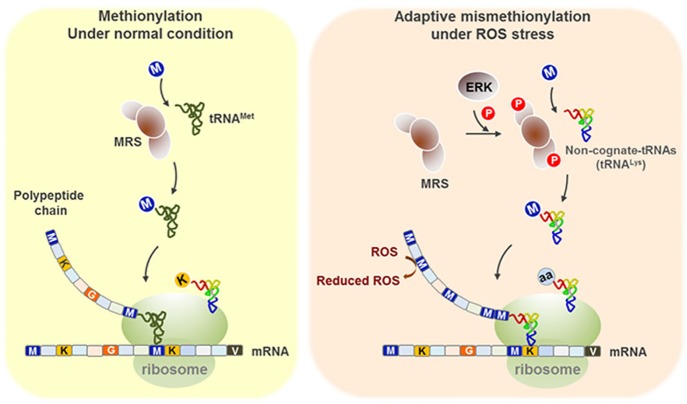
Schematic model for the protective role of MRS under ROS stress. Upon ROS stress, ERK is activated and phosphorylates MRS at the Ser209 and Ser825 residues. Phosphorylated MRS enhances the mischarging of Met on non-methionyl tRNAs, such as tRNALys. Met carried by non-cognate tRNAs is incorporated into growing polypeptides during translation and used as a ROS scavenger, protecting cells from oxidative damage and apoptosis.